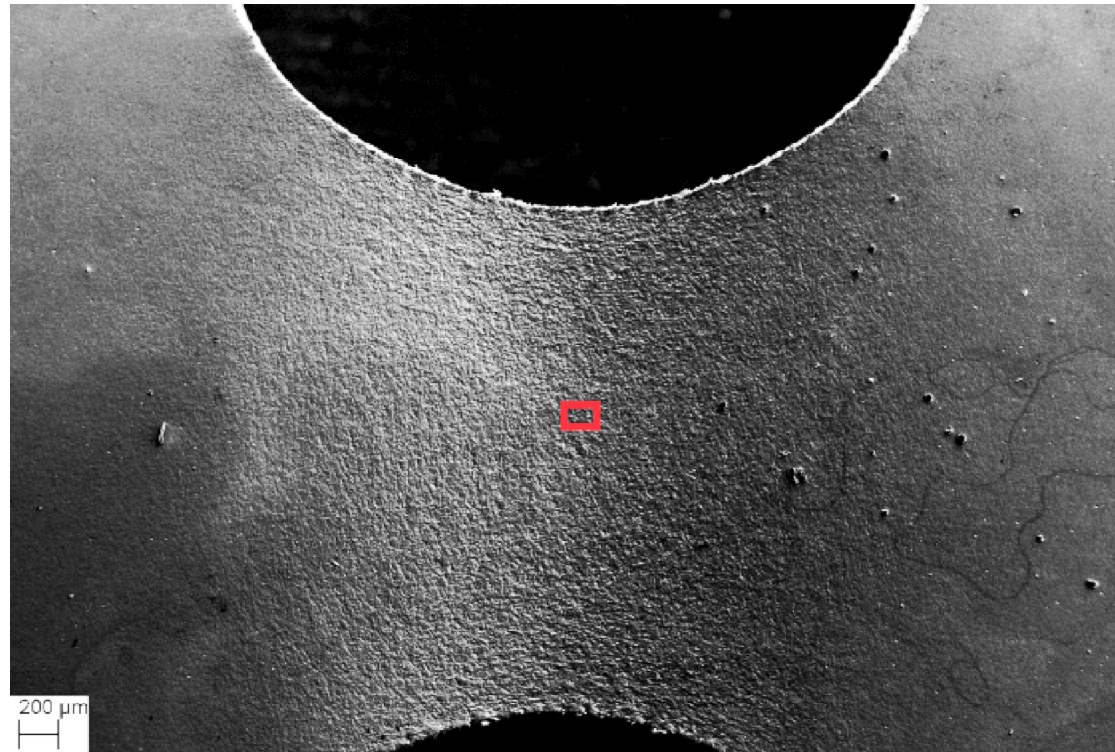
Figure 4. Area observed during the two in situ SEM tensile tests. The red square has the dimensions 160 µm × 120 µm and is from the test on the etched specimen.